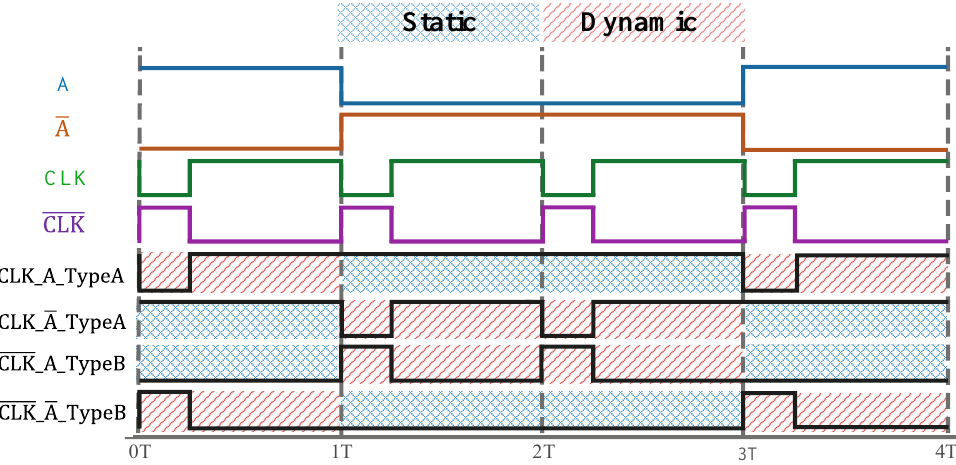
Figure 5. Input and output waveforms of the controllers used in the Type-A and Type-B stages. Each controller, formed by three transistors M1–M3, is designed with Pass Transistor Logic (PTL) [35]. Transistors M1 and M3 allow the switch between dynamic and static mode by making the enable signal either A or A . The controllers also have a transmission gate (M1 and M2), and it is enabled to operate in the dynamic mode, thus passing a full swing CLK signal, whether it is a logic “0” or “1”. Note that the energy consumed by the controllers is minimum owing to the reduced number of transistors (i.e., small area overhead). Only the input signals ( A , A , CLK , and CLK ) were used as control signals and as transistor supply